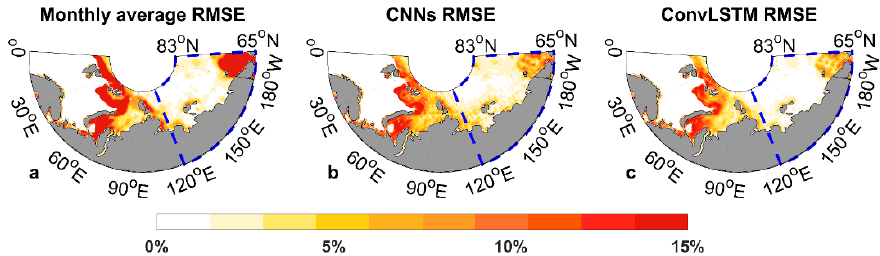
Figure 11. Comparison of the monthly average ( a ), CNNs ( b ), and ConvLSTM ( c ) RMSEs of the Northeast Passage during December. The gray in the figure represents the land, and the red represents the RMSE of each model in December. The area marked by the blue dotted line is the key contrast area in the following.